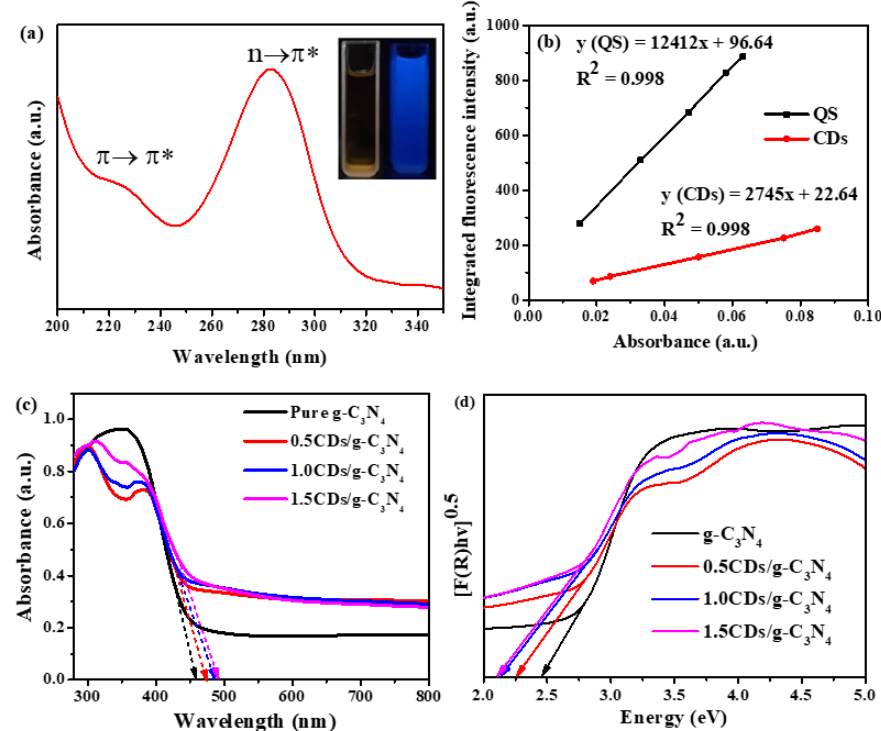
Figure 5. The ( a ) UV-Vis absorption spectrum of the CDs solution. The inset illustrates the fluores- cence of the CDs solution under daylight (left) and UV Light (right), ( b ) plot of integrated fluores- cence intensity versus the corresponding absorbance for QS and CDs, ( c ) UV-vis absorption spectra and ( d ) the Kulbelka-Munk plot of the of the CDs/g-C 3 N 4 photocatalysts. The UV - Vis absorption spectra of the CDs/g - C 3 N 4 photocatalysts are illustrated in Figure 5c. The pure g - C 3 N 4 and the CDs/g - C 3 N 4 photocatalysts displayed an absorption edge at around 459, 473, 486, and 490 nm, respectively. The bandgap energy of pure g - C 3 N 4 and CDs/g - C 3 N 4 photocatalysts were measured from optical absorption, and the cor- responding plots are provided in Figure 5d. The Kulbelka-Munk plot was used to evaluate the photocatalyst bandgap, where (F(R)*hv) 1/2 was plotted against photon energy (hv). Drawing a tangent line of each curve, the band gap of each photocatalyst was obtained from the x-intercept. The ability of the synthesized photocatalysts to harvest light follows the relative order: 1.5CDs/g - C 3 N 4 (2.11 eV) > 1.0CDs/g - C 3 N 4 (2.14 eV) > 0.5CDs/g - C 3 N 4 (2.26 eV) > g - C 3 N 4 (2.46 eV). The changes in band edge absorption and energy after the addition